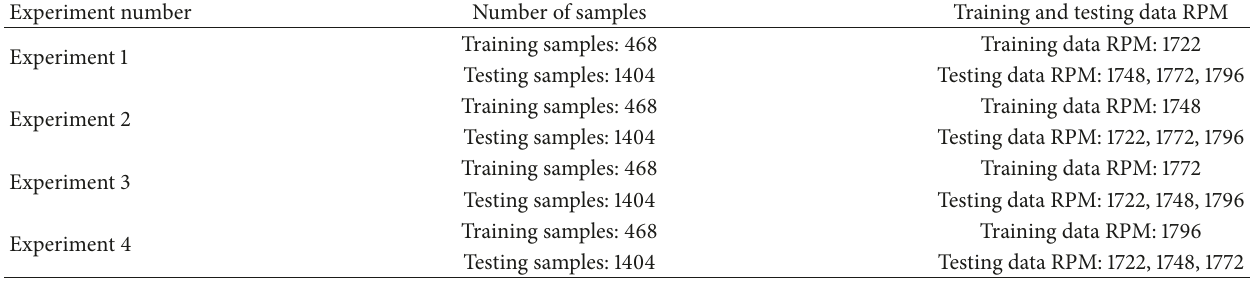
Table 2: Description of the experiments performed using data obtained for the different RPM values.